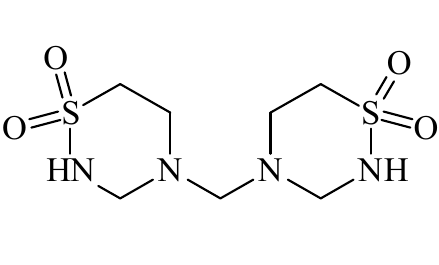
Figure 14. Structure of taurolidine.